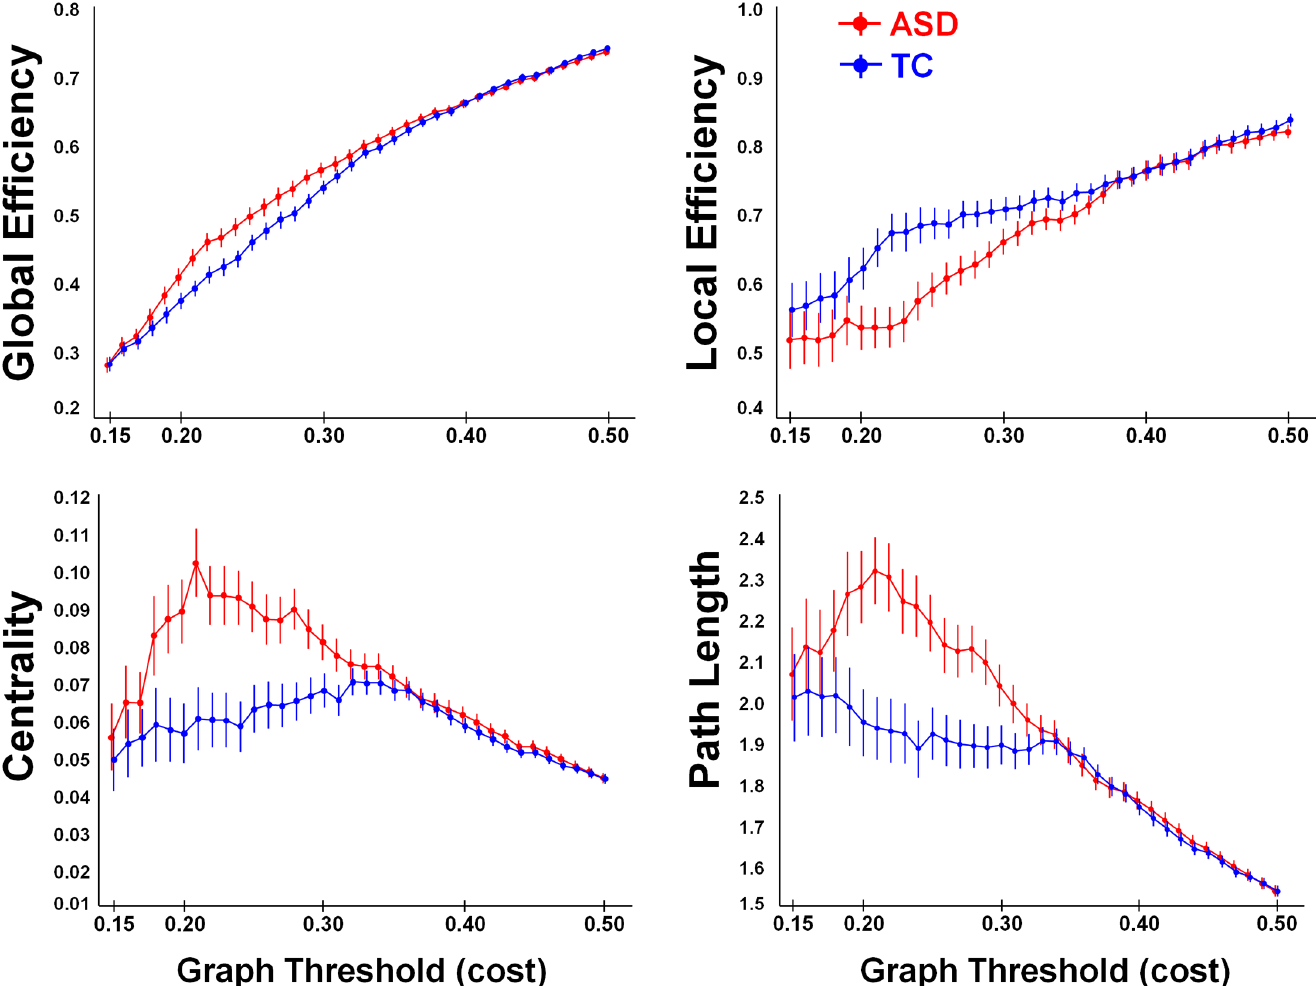
Fig 2. Graph theoretical network analysis using fixed cost thresholds (# 36, between k = 0.15 and k = 0.50). At the low-range cost thresholds (0.20 < k < 0.30), the TC-group (in blue) showed significantly higher local efficiency, shorter average path length and a lower betweenness-centrality, compared to the ASD group (in red). No group differences were revealed at the high cost thresholds ( k >